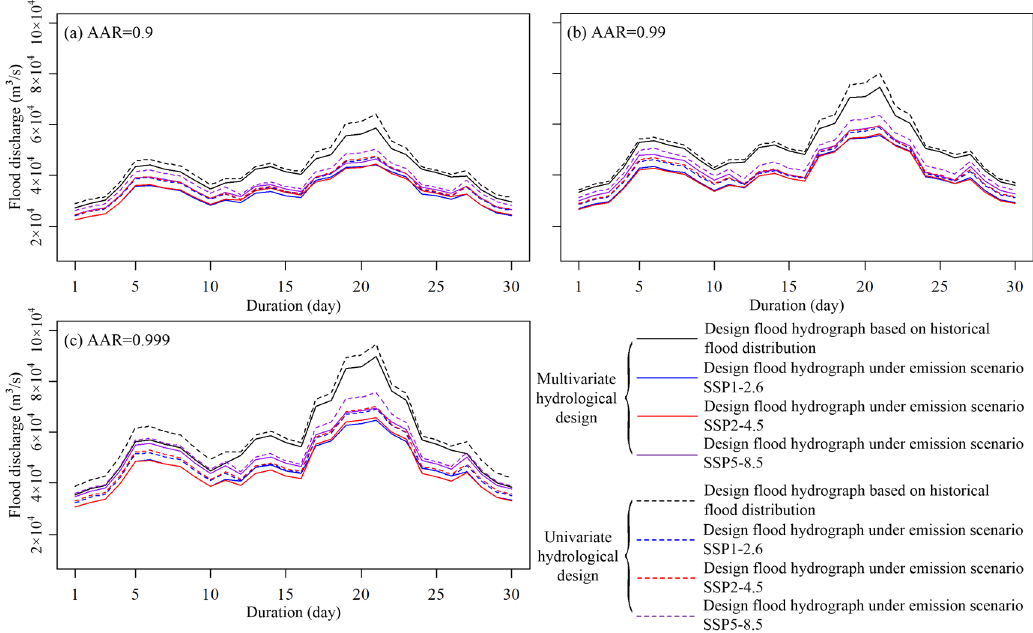
Figure 7. Dam-site design hydrographs associated with AND exceedance probability for the TGR. Panels ( a – c ) display the results for design levels with the AARs of 0.9, 0.99 and 0.999,